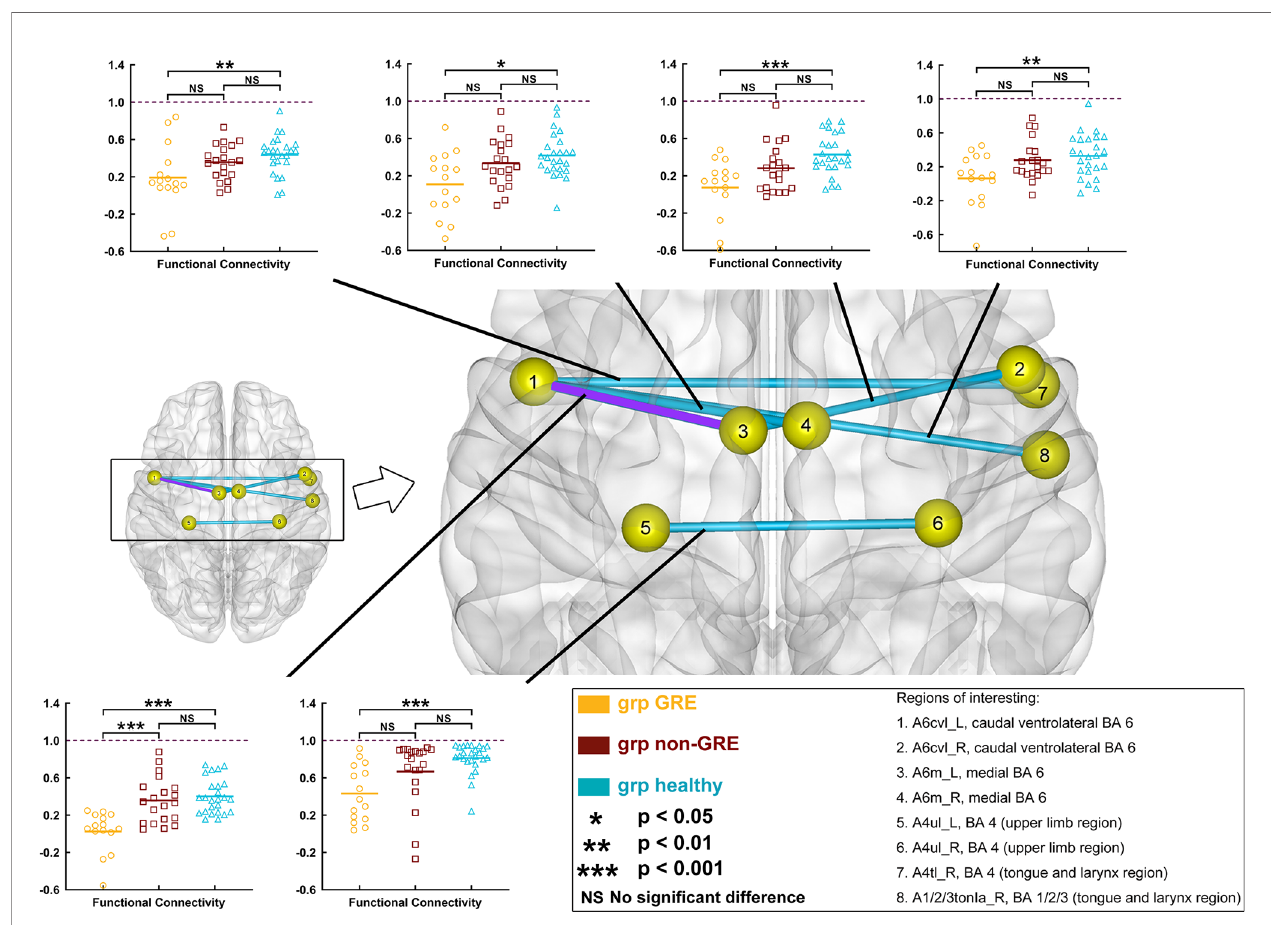
FIGURE 2 | Results of alterations in functional connectivity (FC) when gliomas grew in the left prefrontal lobe. The grp GRE (n = 15), group of patients with glioma- related epilepsy. The grp non-GRE (n = 20), group of patients without glioma-related epilepsy. The grp healthy (n = 25), group of healthy